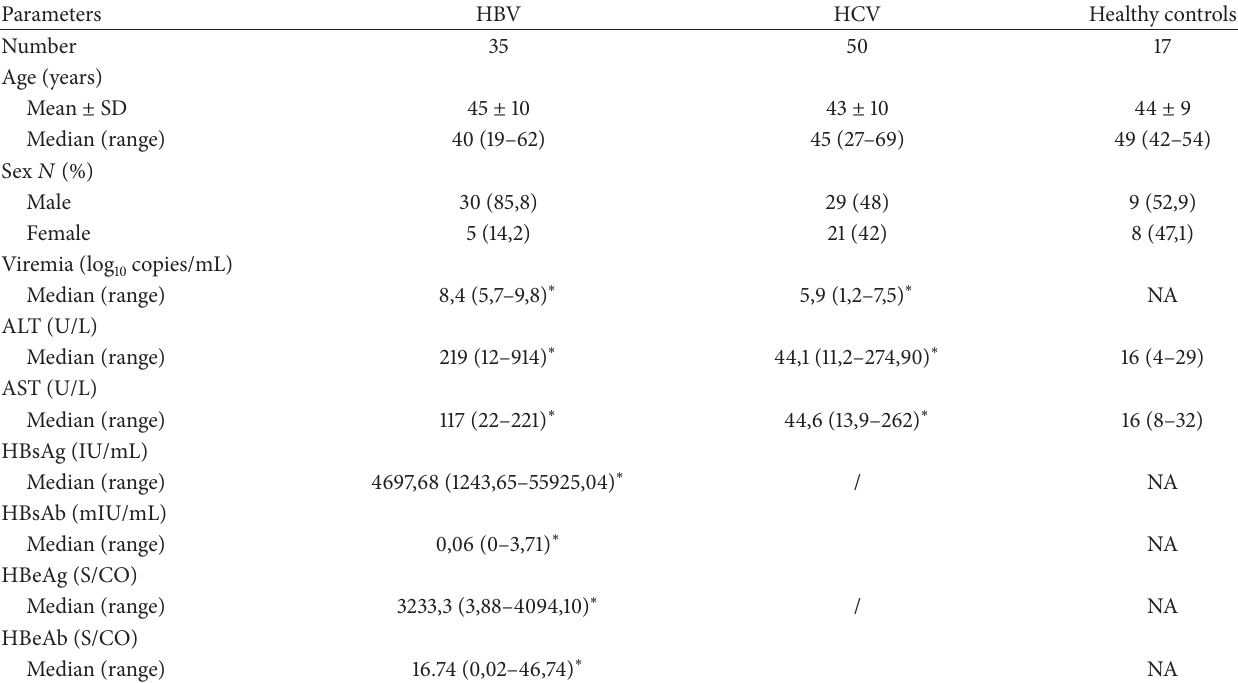
Table 1: Demographic characteristics and clinical features of